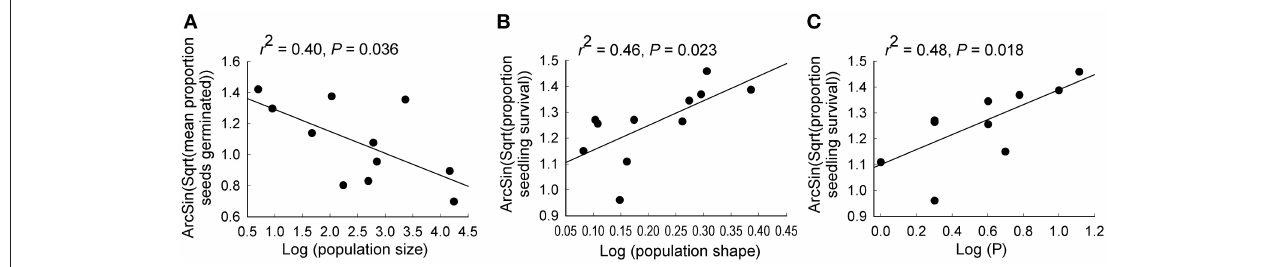
FIGURE 5 | Relationships between (A) population size and seedling survival, (B) population shape and seed germination and (C) bicarbonate extractable P and seedling survival for 11 populations of Eucalyptus wandoo . Regression lines are presented with r 2 - and P -values.